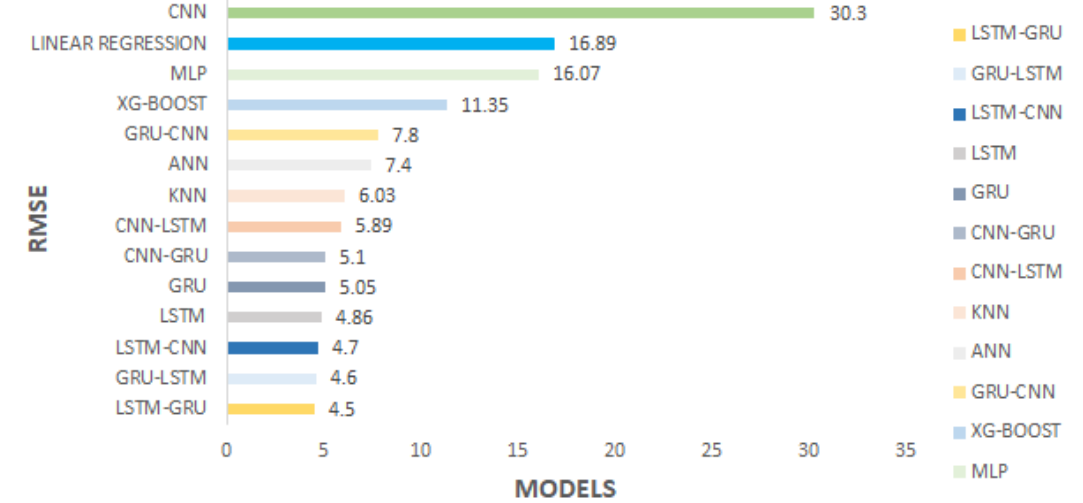
Figure 6. Evaluation metrics of prediction on test data.